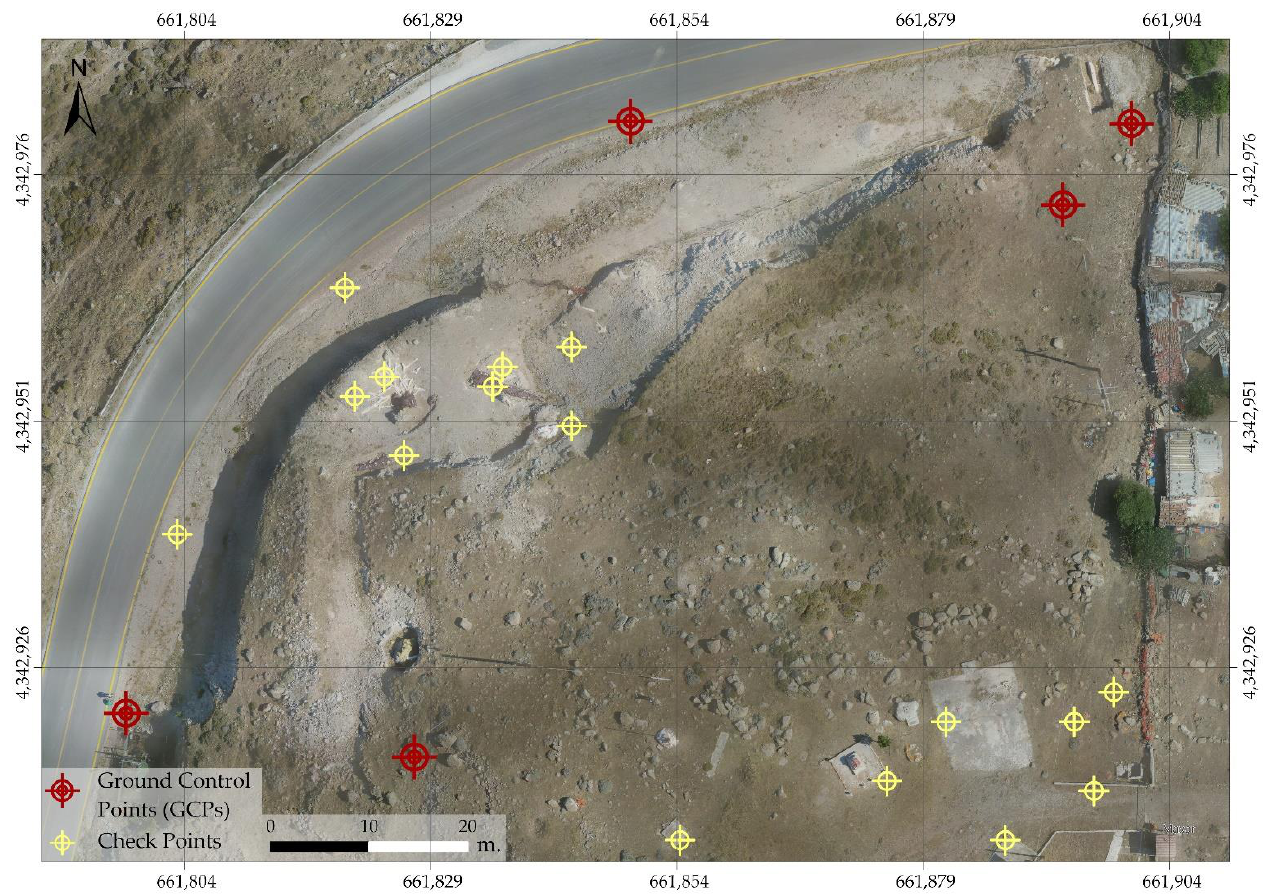
Figure 4. Map with the measurements’ positions of the ground control points and the checkpoints. Based on the 1:120 cartographic scale, in which the entire fossilite ferrous site was mapped, the acceptable error of horizontal and elevation accuracy is 4 cm [80,81]. Table 3 shows the GCPs errors by x, y, z axis and the total RMS for each recording date for the 1:120 cartographic scale. More specifically, the total RMS of the data georeferencing was: